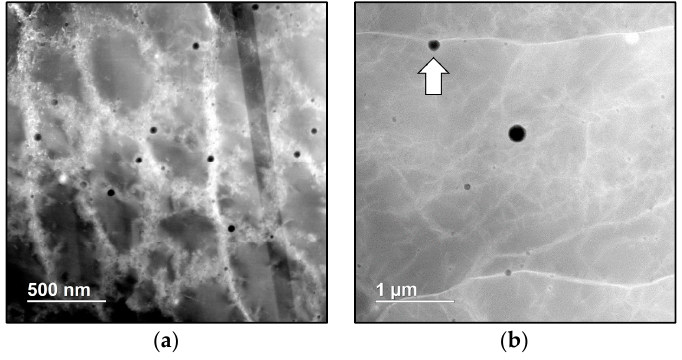
Figure 7. ( a ) Z-contrast scanning transmission electron micrograph showing nano-scale MnO-SiO 2 rhodonite particles distributed along cell boundaries in the as-deposited SLM 316L.; ( b ) Microstructures of SLM 316L heat-treated at 1200 °C for 30 min. The arrow shows a MnO-SiO 2 rhodonite particle acting as an effective Zener-pinning particle that pins the grain boundary.